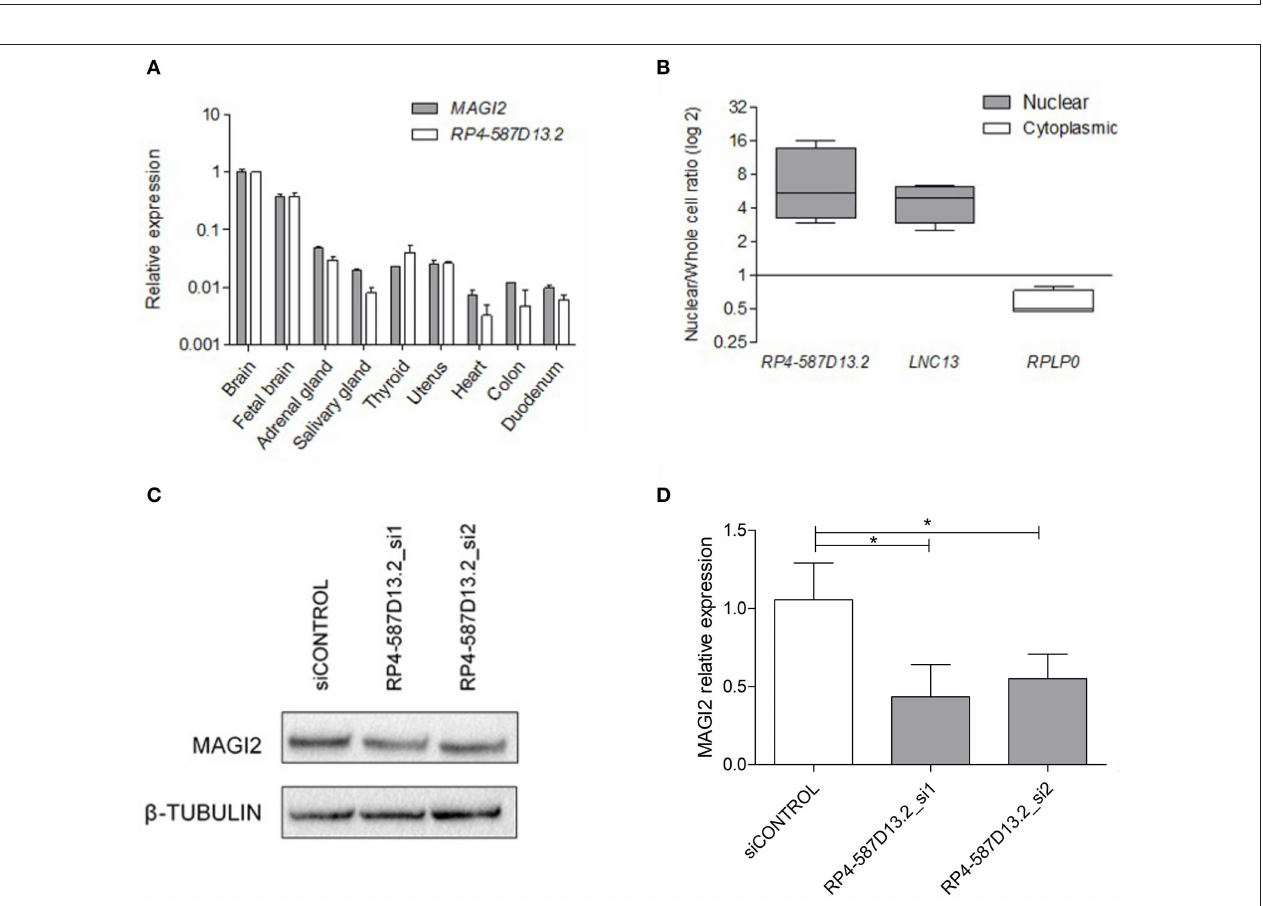
including processed transcripts, pseudogenes, and RNA